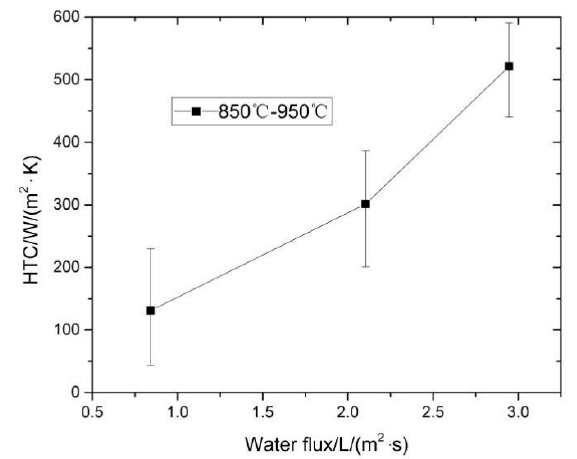
Figure 12. The HTC as a function of water flux.